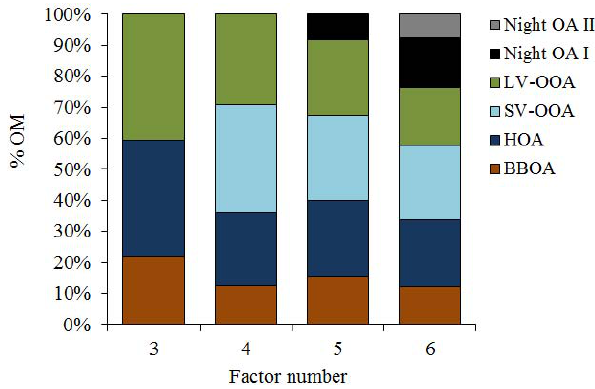
Fig. 5. Summary of OM apportioned by factor